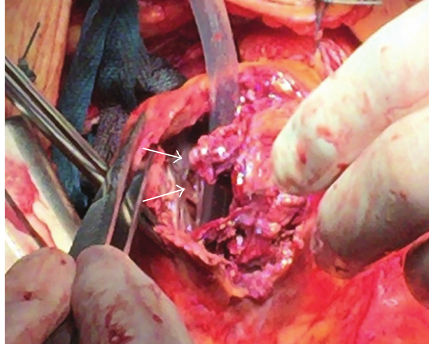
Figure 8: Intraoperative situs showing an ischemic myocardial perforation of the left